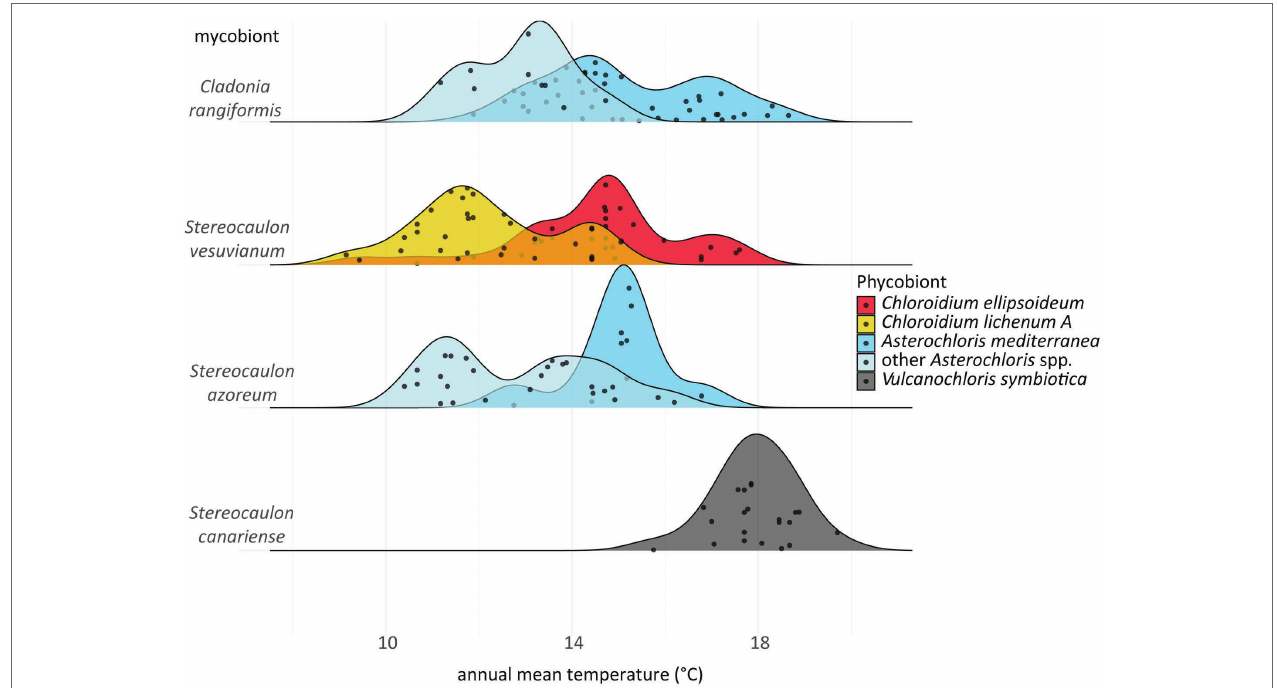
FIGURE 10 | Ridgeplot depicting replacing of phycobionts along the gradient of annual mean